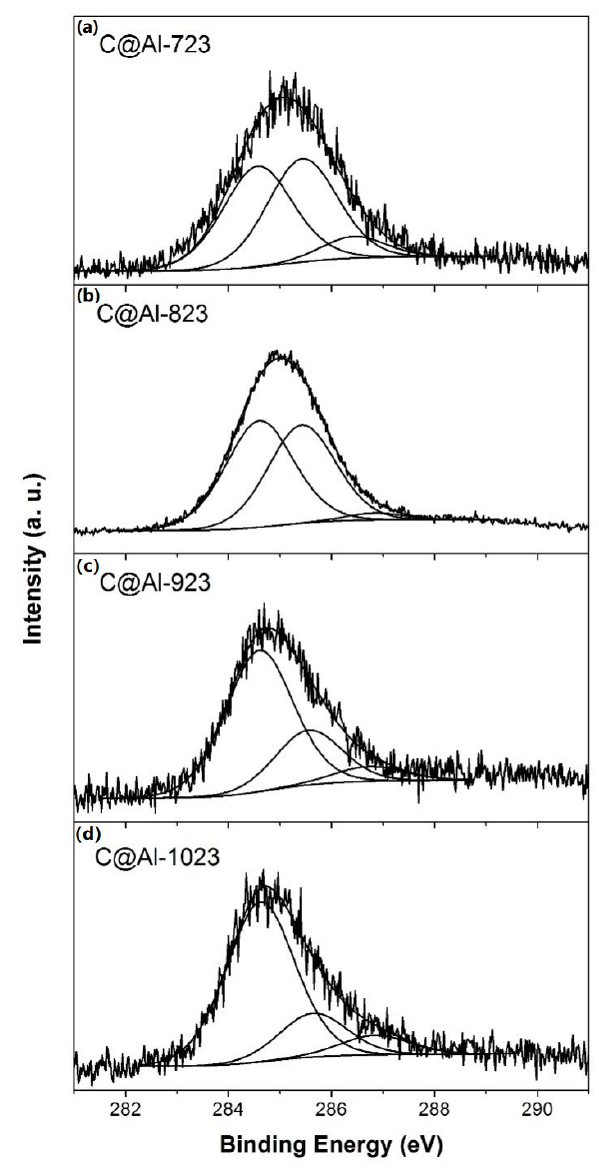
Figure 5. XPS spectra in region C 1s of different samples: ( a ) C@Al-723; ( b ) C@Al-823; ( c ) C@Al-923; ( d ) C@Al-1023.